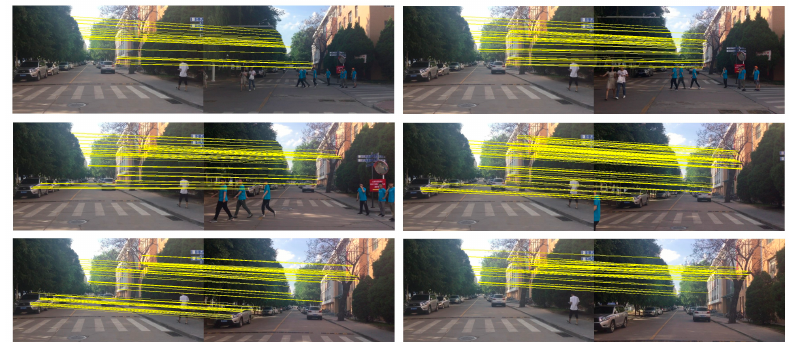
Figure 7. For a particular template (the image on the left part), images taken within a certain distance (the image on the right part) from it will produce a great number of points that match the template image successfully, which reduces the accuracy of positioning.